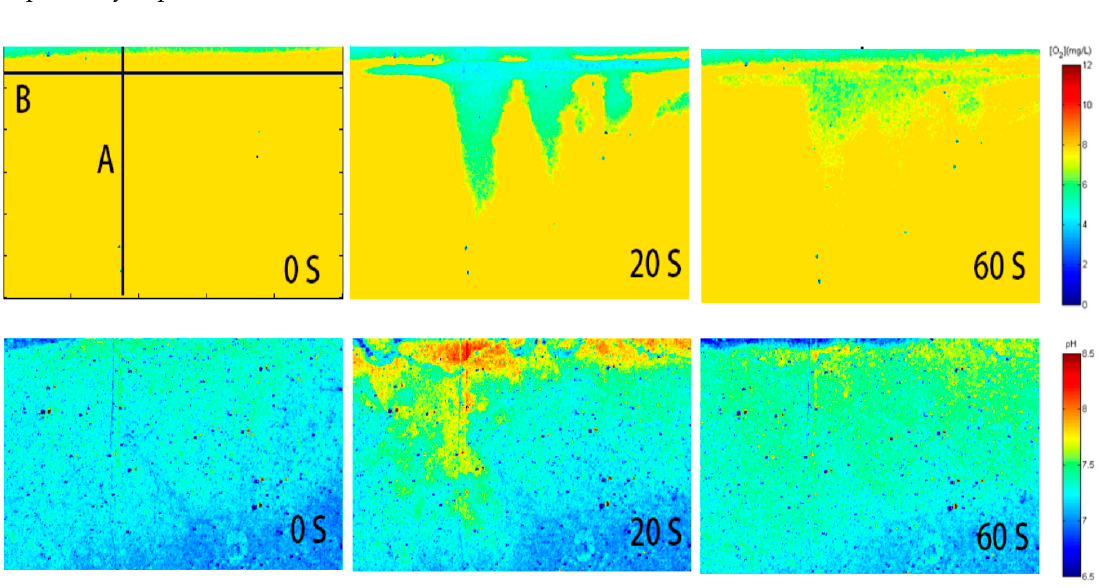
Figure 7. Time series recording of the pH/oxygen distribution. The Line A represented extracted vertical profiles of the raindrops landing area, the Line B indicated the position of air-water interface.